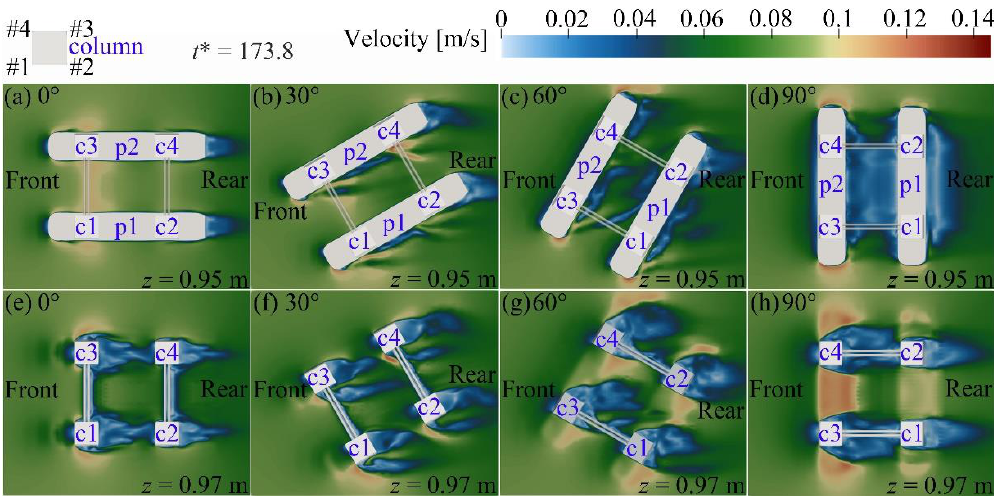
Figure A4. Comparison of the velocity field around the semi-submersible platform at different angles at z = 0.95 m; z = 0.97 m.